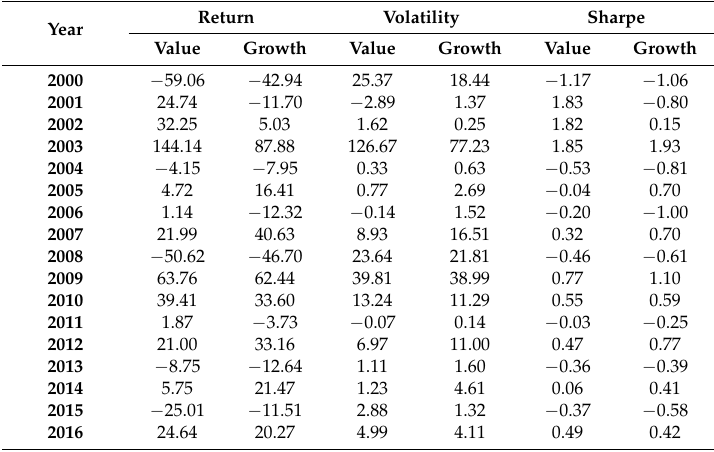
Table 1. Value and growth index risk adjusted performance.